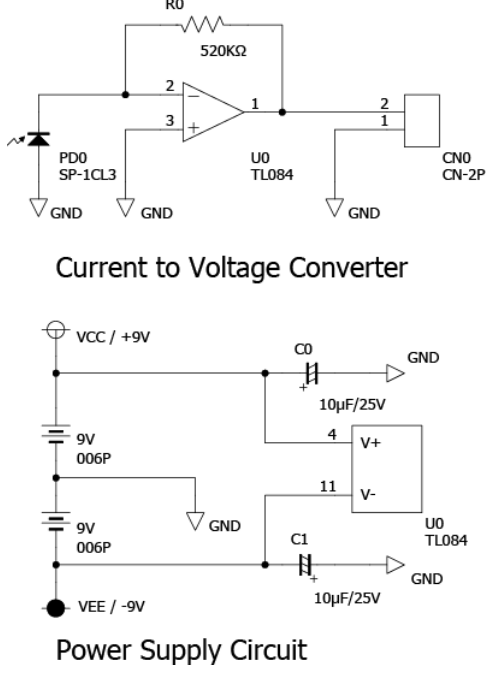
Figure 4. Schematic diagram of the current to voltage